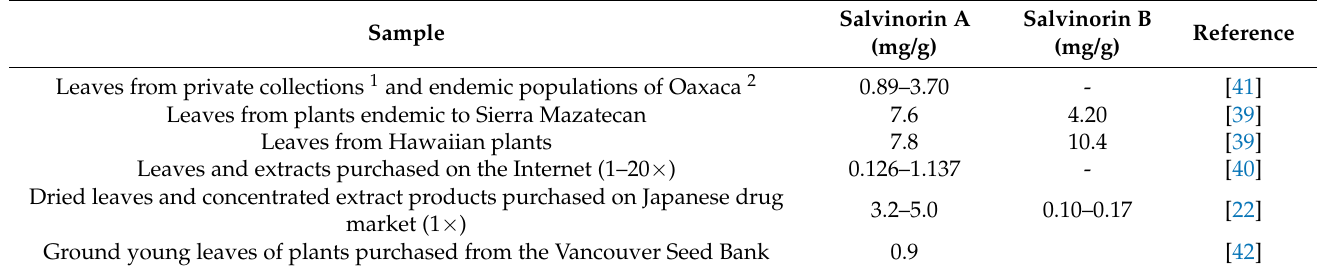
Table 1. Concentrations of salvinorin A and salvinorin B reported in different S. divinorum samples.